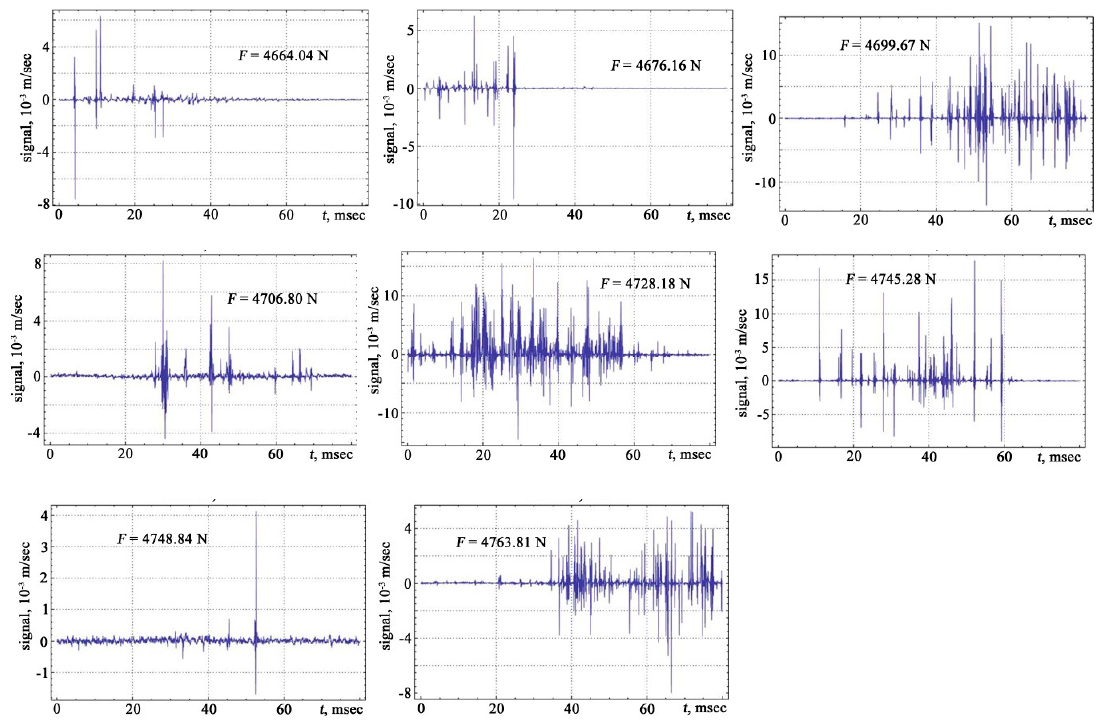
Figure 8. The vibration signals in different parts of the chart of stretching: III—phase of hardening IV